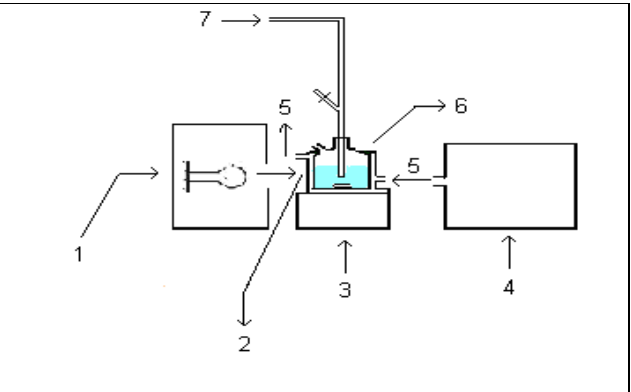
Figure 11. Photocatalytic reactor: (1) medium pressure mercury lamp/halogen lamp; (2) plain window of cell; (3) magnetic stirrer; (4) circulatory thermostat; (5) water; (6) photocell and (7) O 2